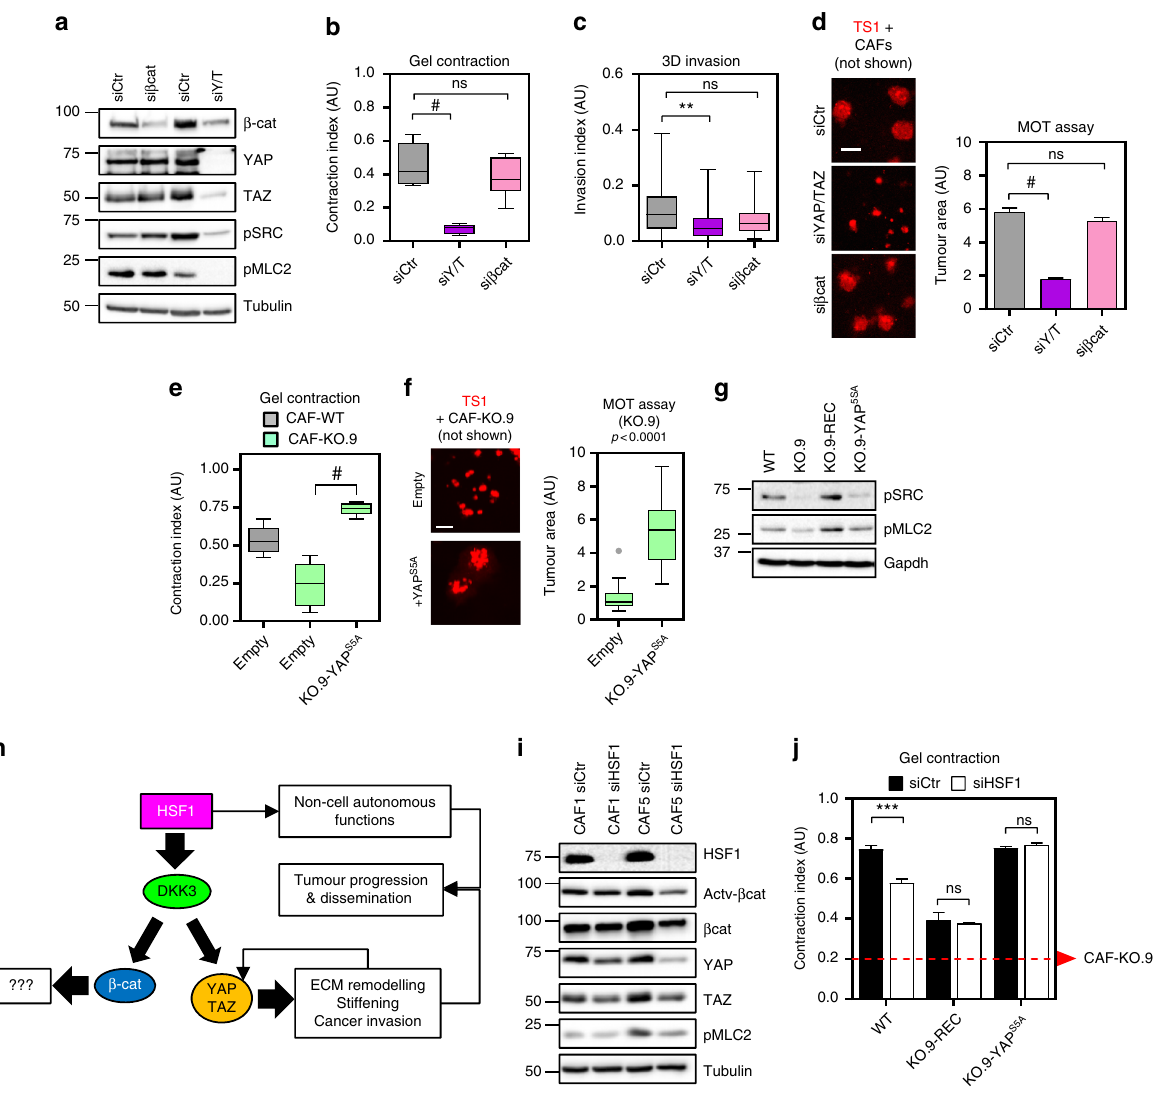
Fig. 6 DKK3 promotes aggressive behaviours in CAFs via YAP/TAZ. a Western blots showing β -catenin, YAP, TAZ, pY416-Src (pSRC), pS19-MLC2 (pMLC2) and Tubulin in CAF1 following transfection with control (siCtr), β -catenin (si β cat; smart-pool) or YAP/TAZ (siY/T; smart-pool) siRNAs. b Tukey boxplot shows gel contraction of CAF1 transfected as in ( a ); n = 8 gels except for siY/T that n = 6. c Tukey boxplot shows invasion index (3D invasion) measured from TS1 spheroids obtained after 3D co-culture with CAF1 transfected as in ( a ); n > 32 individual spheroids out of 3 independent experiments. d Representative images of end-point TS1 (red) MOT co-culture with CAF1 transfected as in ( a ). Scale bar, 100 µ m. Graph shows the area of colonies. Bars represent mean ± SEM ( n = 570 or more colonies from at least 3 independent experiments). e Tukey boxplot shows gel contraction index of CAF-WT or CAF-KO.9 stably expressing empty vector (empty) or constitutive active YAP mutant (YAP S5A ); n = 7 gels or more. f Representative images of end-point TS1 (red) MOT co-culture with CAF-KO.9 stably expressing empty vector (empty) or YAP S5A . Scale bar, 100 µ m. Tukey boxplot shows the area of colonies; n = 28 or more colonies from at least 3 independent experiments. g Western blot showing levels of pY416-Src (pSRC), pS19-MLC2 (pMLC2) and Gapdh in CAF-WT or CAF-KO.9 stably expressing empty vector (KO.9), DKK3 (KO.9-REC), or YAP S5A . h Schematic diagram showing the model integrating our fi ndings. HSF1 in CAFs upregulates DKK3 which in turn potentiates YAP/TAZ and β -catenin signalling. YAP promotes actomyosin contractility leading to ECM remodelling and cancer cell growth and invasion. The role of β -catenin is still undetermined. i Western blots show Hsf1, non- phospho (active) β -catenin (Ser33/37/Thr41), β -catenin, YAP, TAZ, pS19-MLC2 (pMLC2) and Tubulin in murine CAF1 and CAF5 after transfection with control (siCtr) or Hsf1 (smart-pool) siRNAs. j Graph shows gel contraction of CAF-WT, CAF-KO.9-REC and CAF-KO.9-YAP S5A after transfection with control (siCtr) or Hsf1 (smart-pool) siRNAs. Bars represent mean ± SEM ( n = 3 or more). A dashed red line indicates the average contraction by KO.9 CAFs. For all graphs, * P < 0.05; ** P < 0.01; *** P < 0.001; # P < 0.0001; n.s., non-signi fi